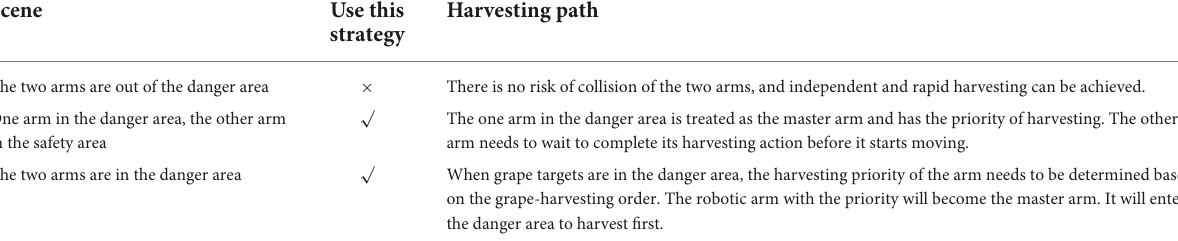
TABLE 1 Different strategies for grape targets in different areas. Scene Use this